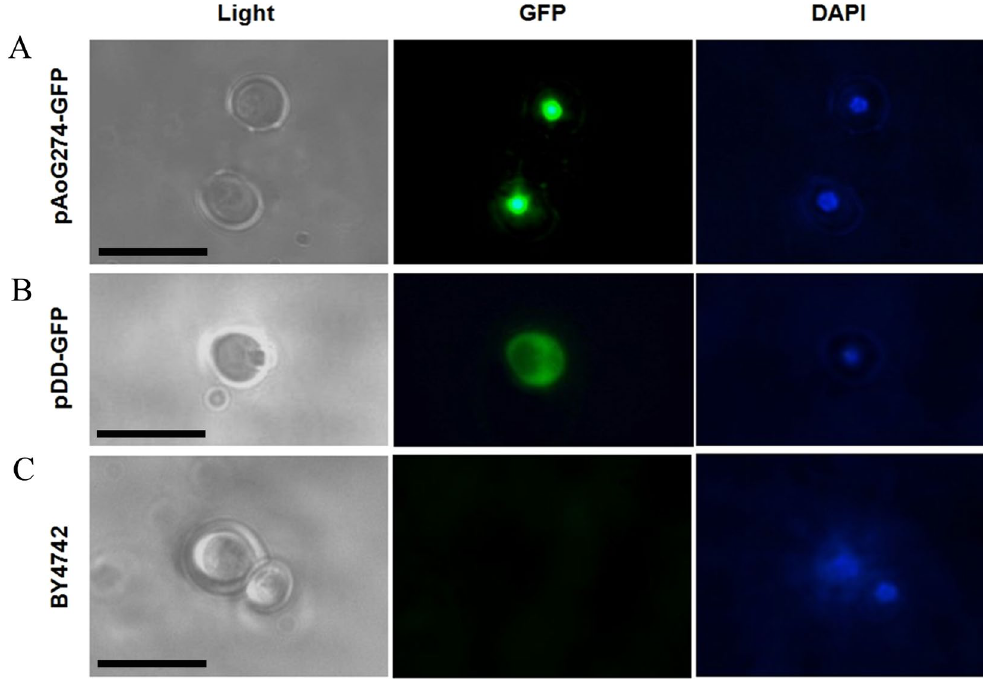
Figure 5. Location of 76g274p-GFP in Saccharomyces cerevisiae . ( A ) The genes 76g274 and gfp were co- expressed in S. cerevisiae BY4742. ( B ) The gene gfp was expressed in S. cerevisiae BY4742. ( C ) The original strain BY4742. Bar: 10 µ m.